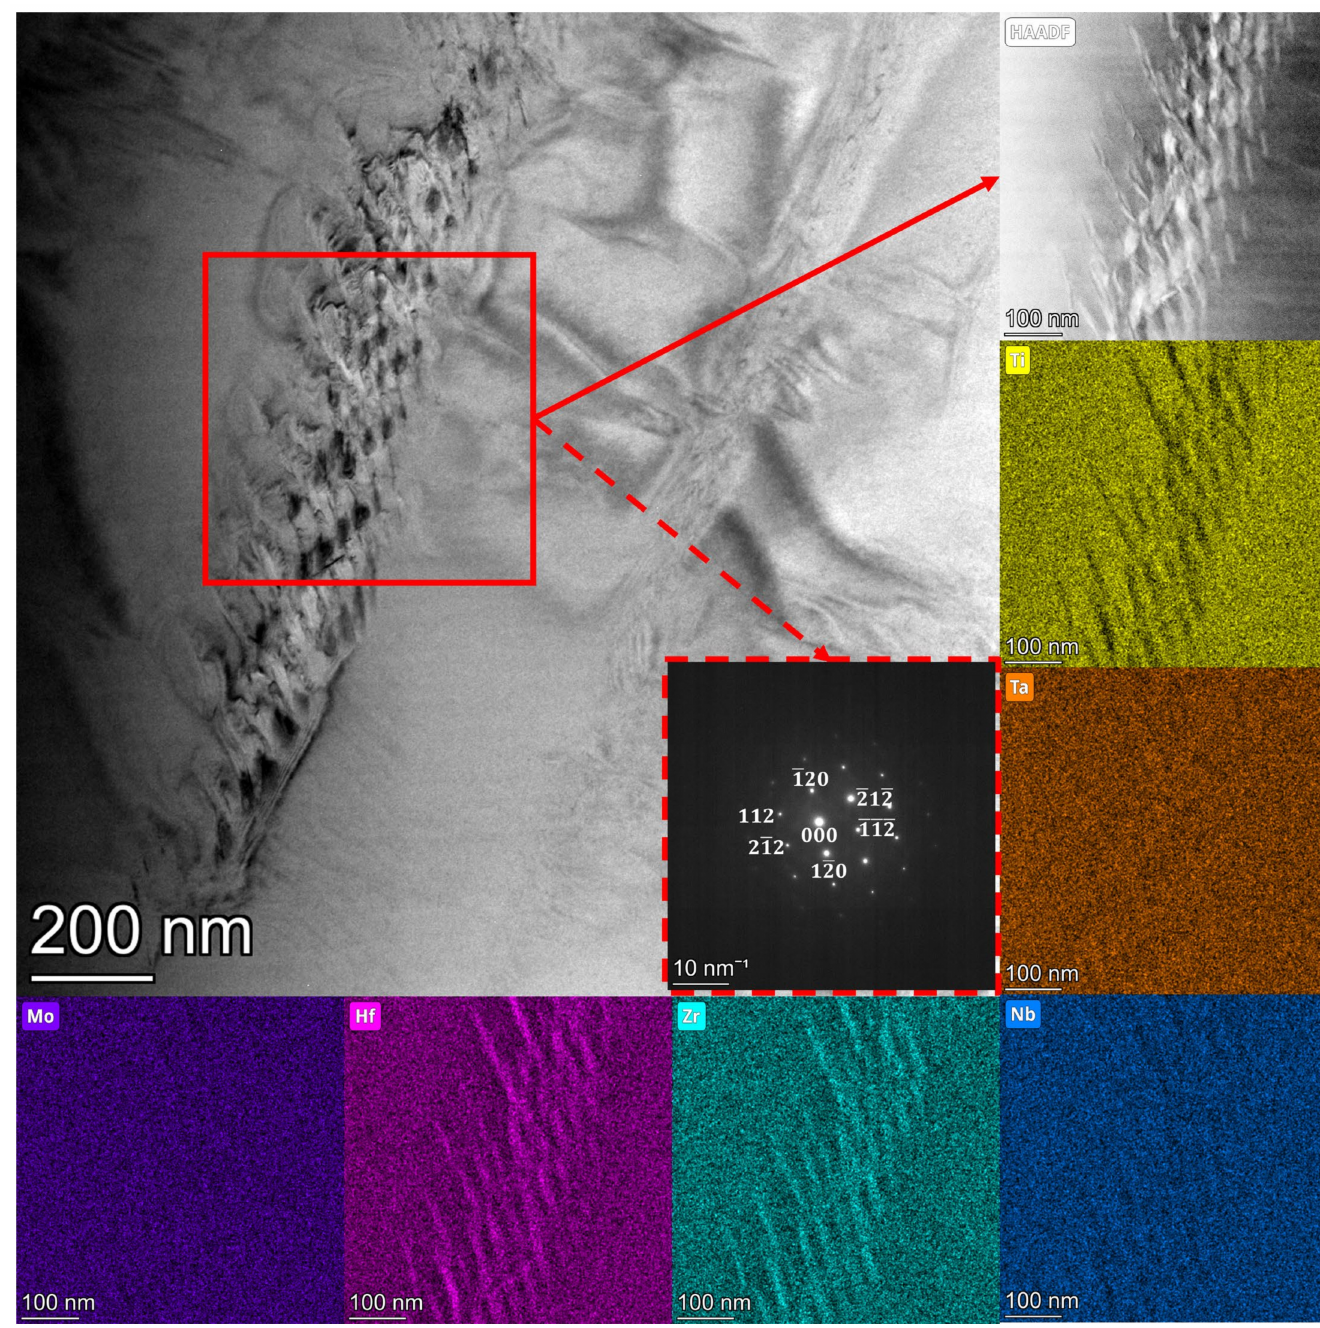
Figure 5. Bright-field and indexed SAED image of Hf-Zr recorded in TEM mode with the corre- sponding STEM high-angle annular dark-field image (HAADF), and elemental distribution maps for Mo_15